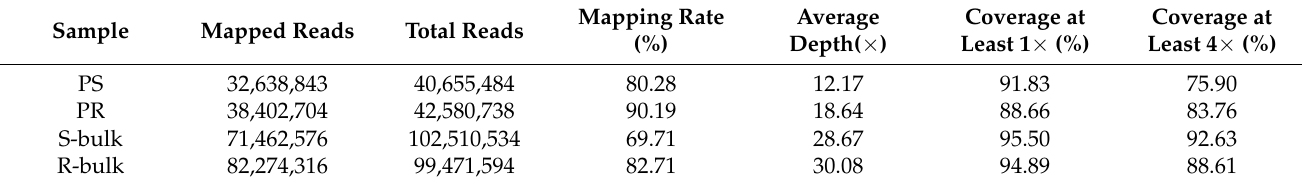
Figure 3. Distribution density map of SNPs on each chromosome within a sliding window of 100 kb. Note: Ordinates represent chromosomes 1 to 10, the abscissa represents the physical location of the chromosome and different colors show the density of SNPs within a sliding window of 100 kb. Table 2. Depth and coverage of re-sequencing